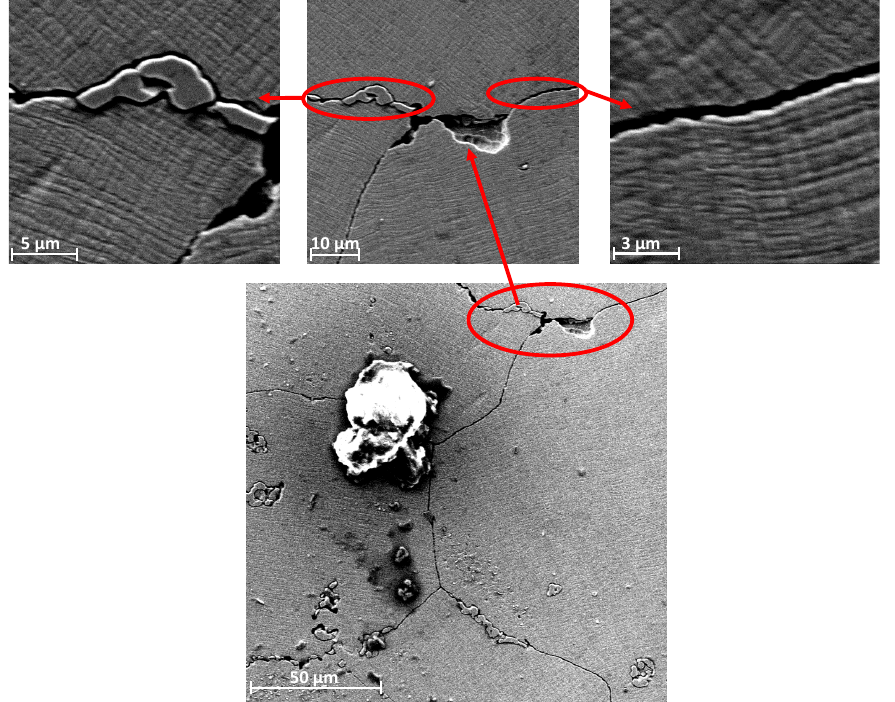
Figure 11. An exemplary view of the topography of the second zone surface with visible areas of destruction, artefacts, and cracks.